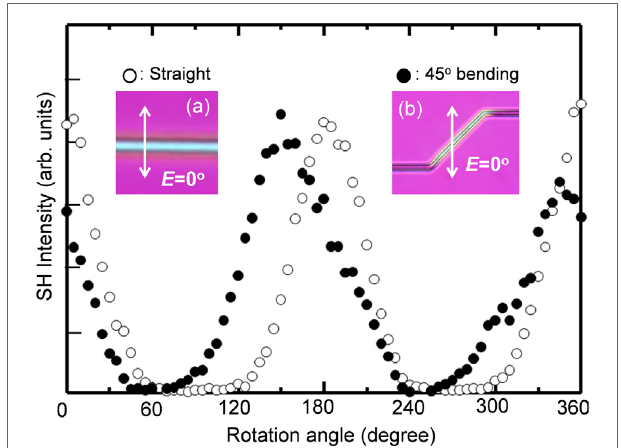
FigUre 1 | azimuthal dependence of shg signals for the straight and bending (bending angle: 45°) lines consisting of β -BBO crystals in the glass . (a,B) are conventional POM photographs for these